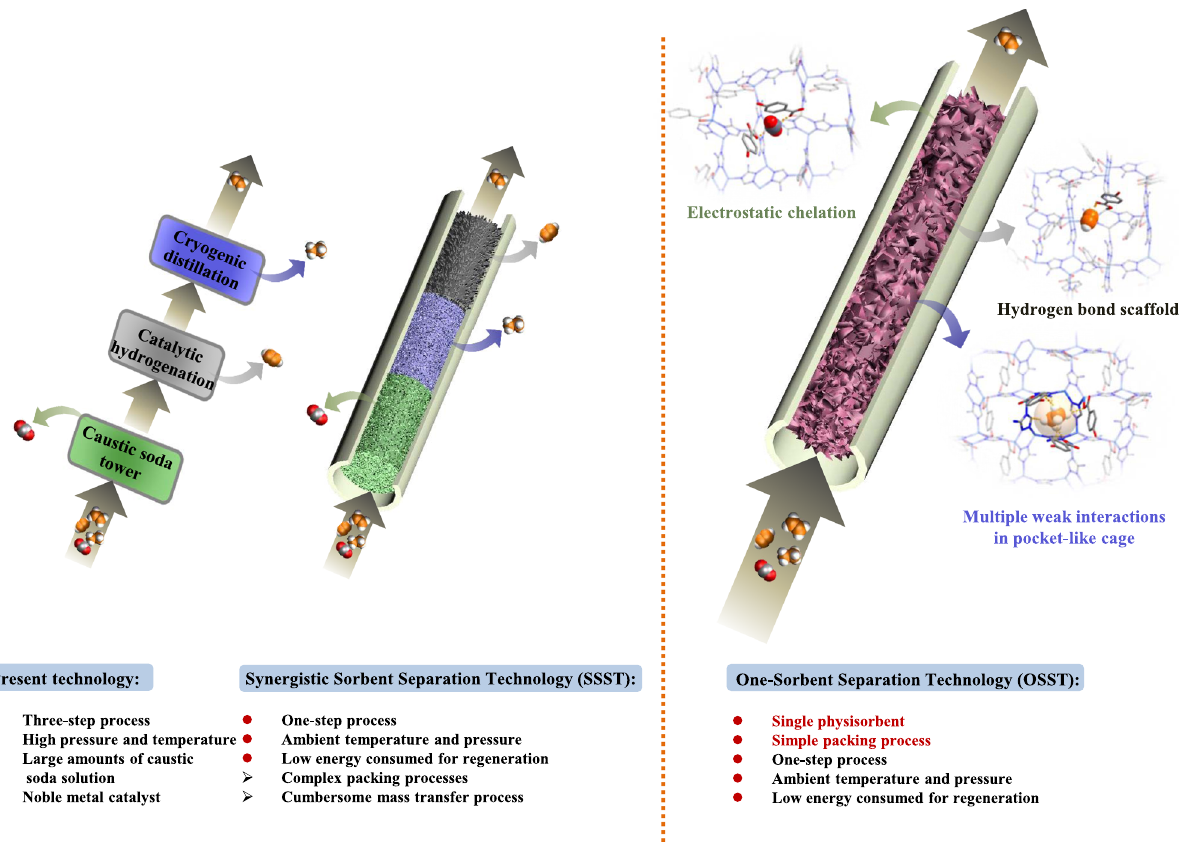
Fig. 1 Comparison of ethylene puri fi cation technologies. State-of-the-art separation technology is compared to synergistic sorbent separation technology (SSST) and “ one-sorbent separation technology ” , OSST.